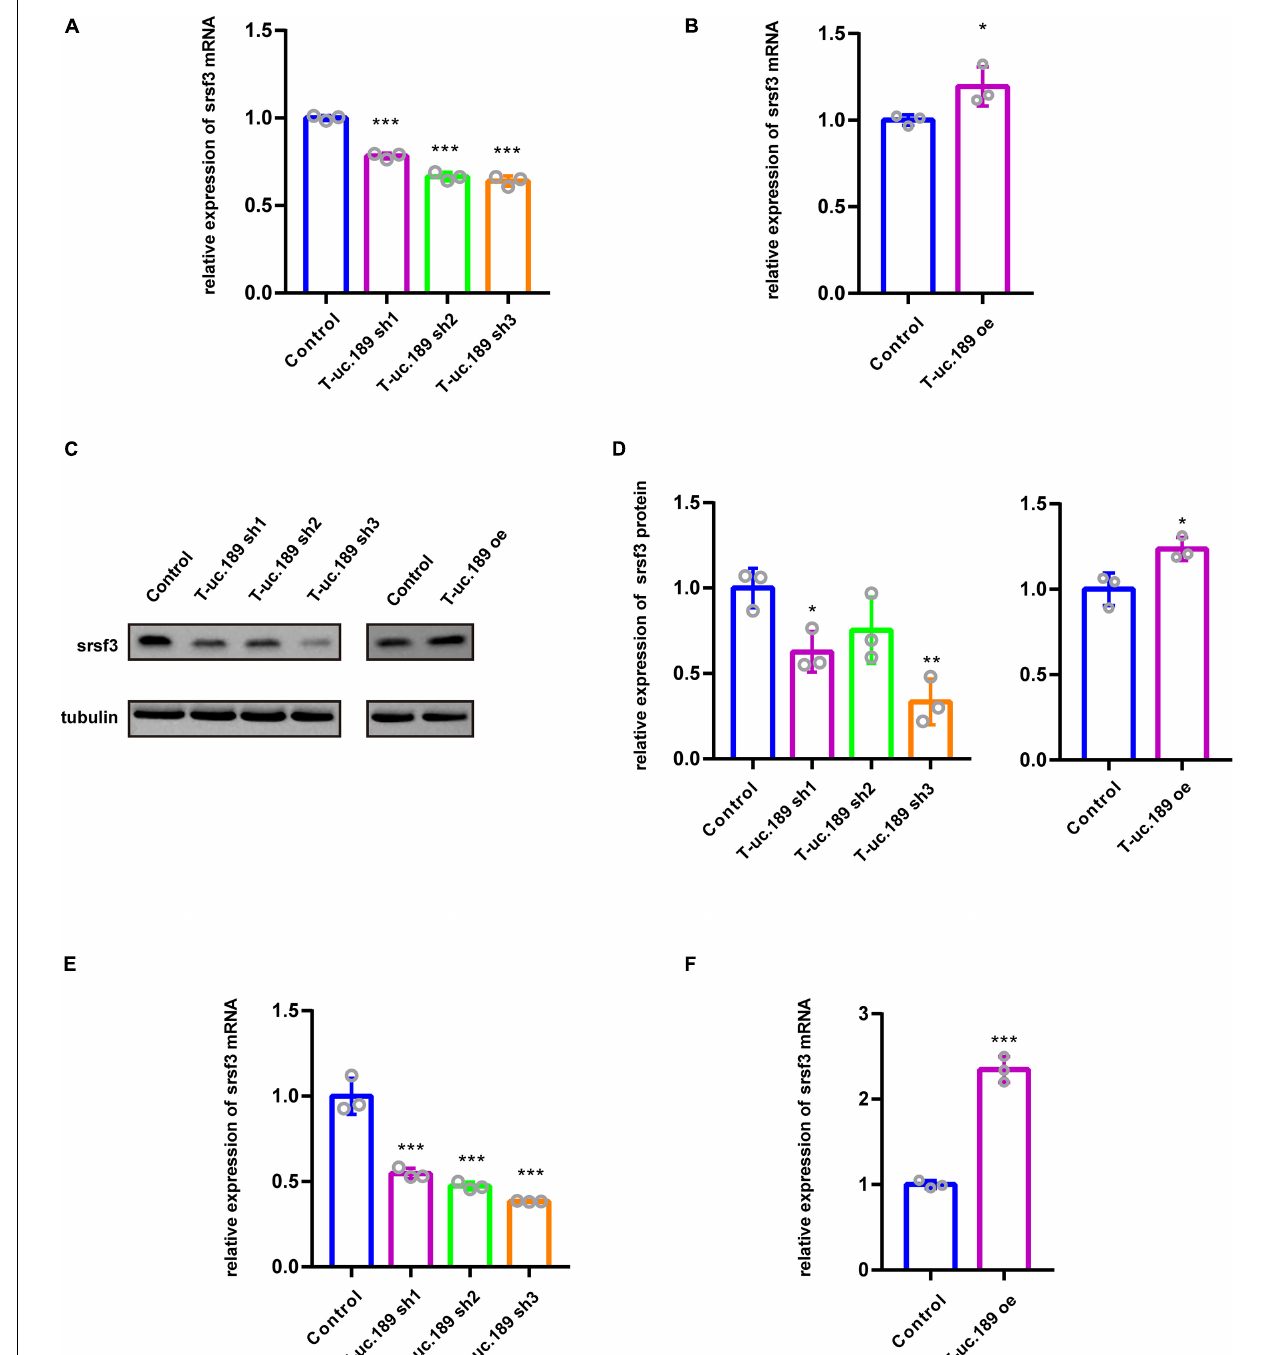
FIGURE 4 | T-uc.189 positively regulates the expression of Srsf3 . (A) The relative mRNA expression of Srsf3 in T-uc.189 knockdown NIE-115 cells compared with the control. (B) The relative mRNA expression of Srsf3 in T-uc.189-overexpressing NIE-115 cells compared with the control. (C) Western blot assay of the relative protein expression of Srsf3 in T-uc.189 knockdown and overexpression NIE-115 cells compared with the control. (D) Statistical analysis of Srsf3 protein expression as determined by Western blot. (E) The relative mRNA expression of Srsf3 of T-uc.189 knockdown in the cortex compared with the control. (F) The relative mRNA expression of Srsf3 of T-uc.189-overexpression in the cortex compared with the control. n ≥ 3 independent biological repeats. The results are expressed as the mean ± SD, and comparisons were performed by Student’s t -test or ANOVA. The statistically significant P values are shown as * P < 0.05, ** P < 0.01 or *** P <